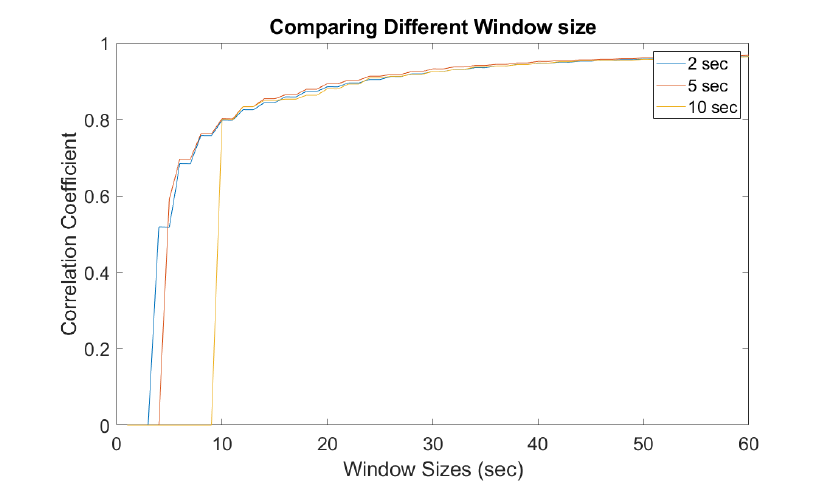
Figure 10. Window sizes for power and original audio.